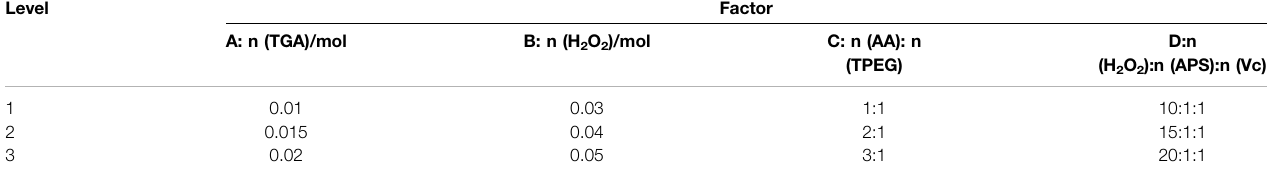
TABLE 2 | Factors and levels of factorial design.